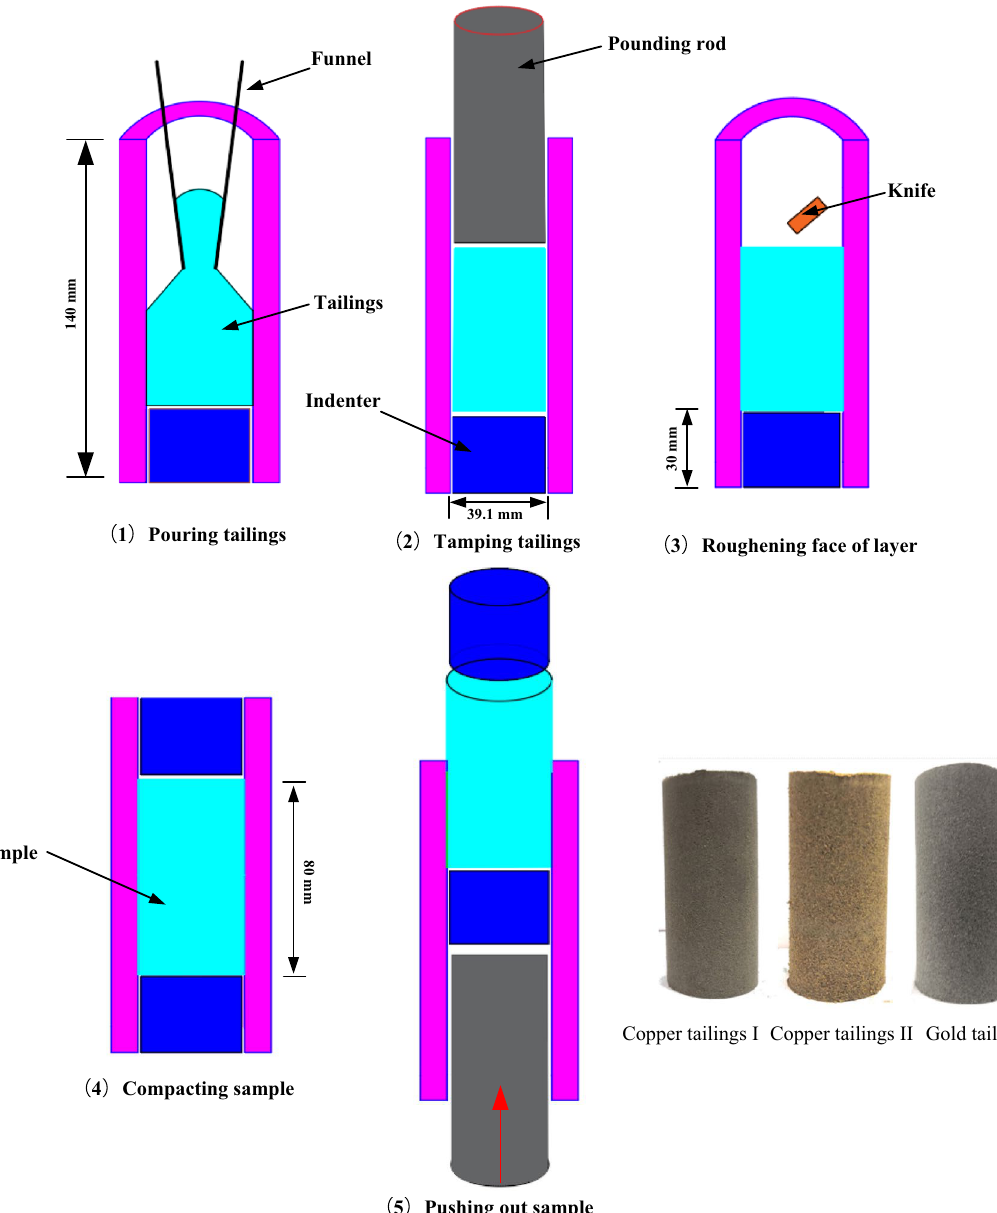
Figure 4. Sample preparation and prepared